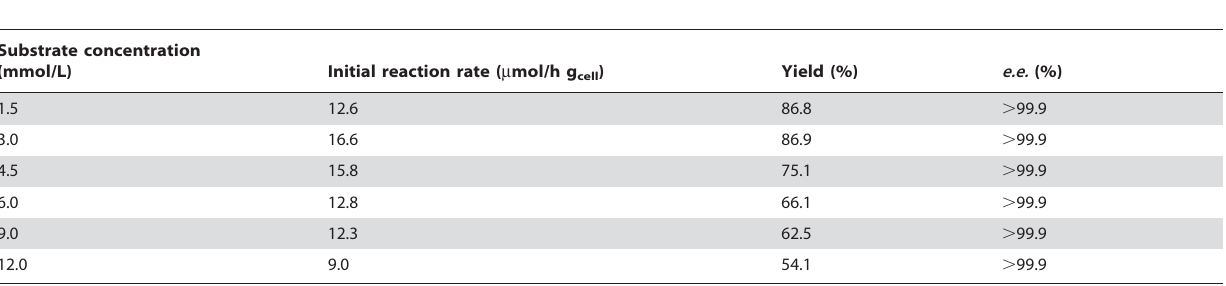
Table 2. Effect of substrate concentration on the bioreduction of TMSB with immobilized Candida parapsilosis cells.